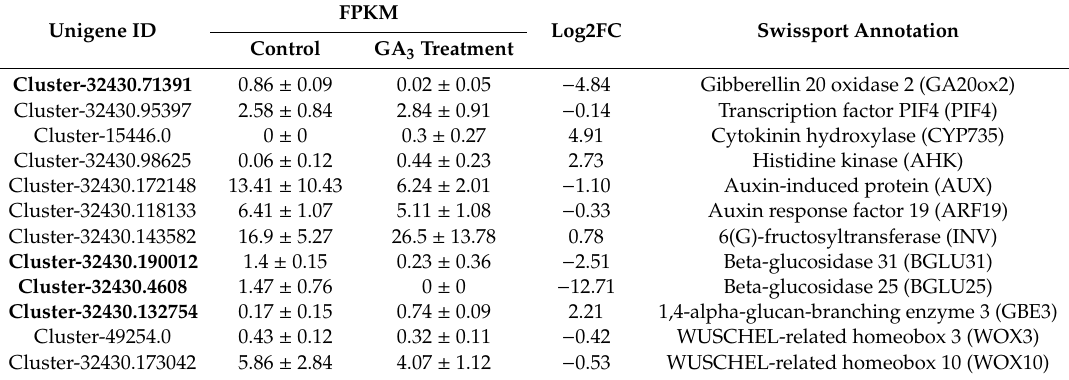
FPKM represents unigene expression level that is normalized by FPKM (fragments per kilobase per million mapped reads) approach. The unigenes in bold are di ff erentiated expression genes (DEGs) between control and GA 3 treatment samples at 2 days after treatment.